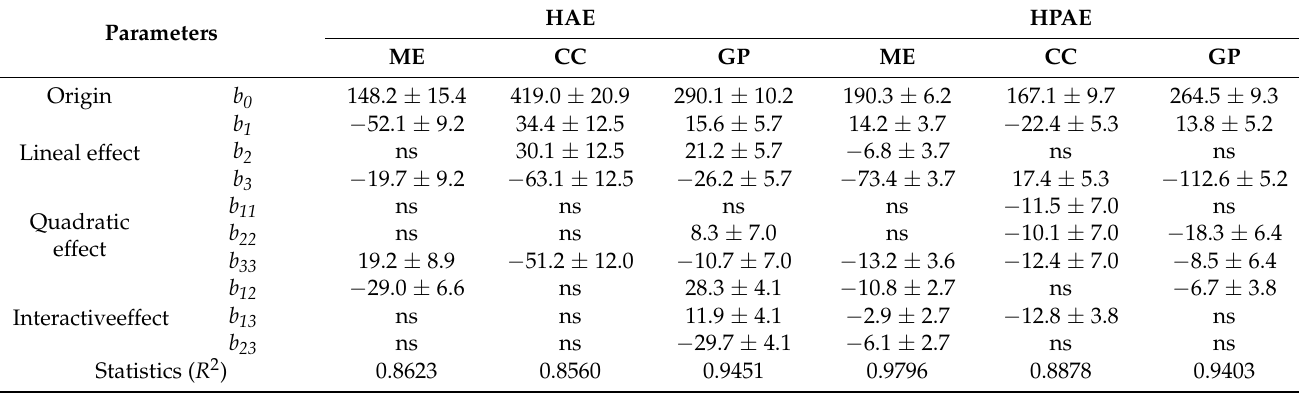
Table 4. Parametric results of the polynomic model of second order of Equation (2) for the extraction techniques HAE and HPAE, in terms of the extraction performance for the response value ( Y , yield), for each one of the algae ( Y ME , Y CC and Y GP ) according to the CCCD with 5 range levels (Table 1). Also, statistic information about the adaptation process of the model is shown.